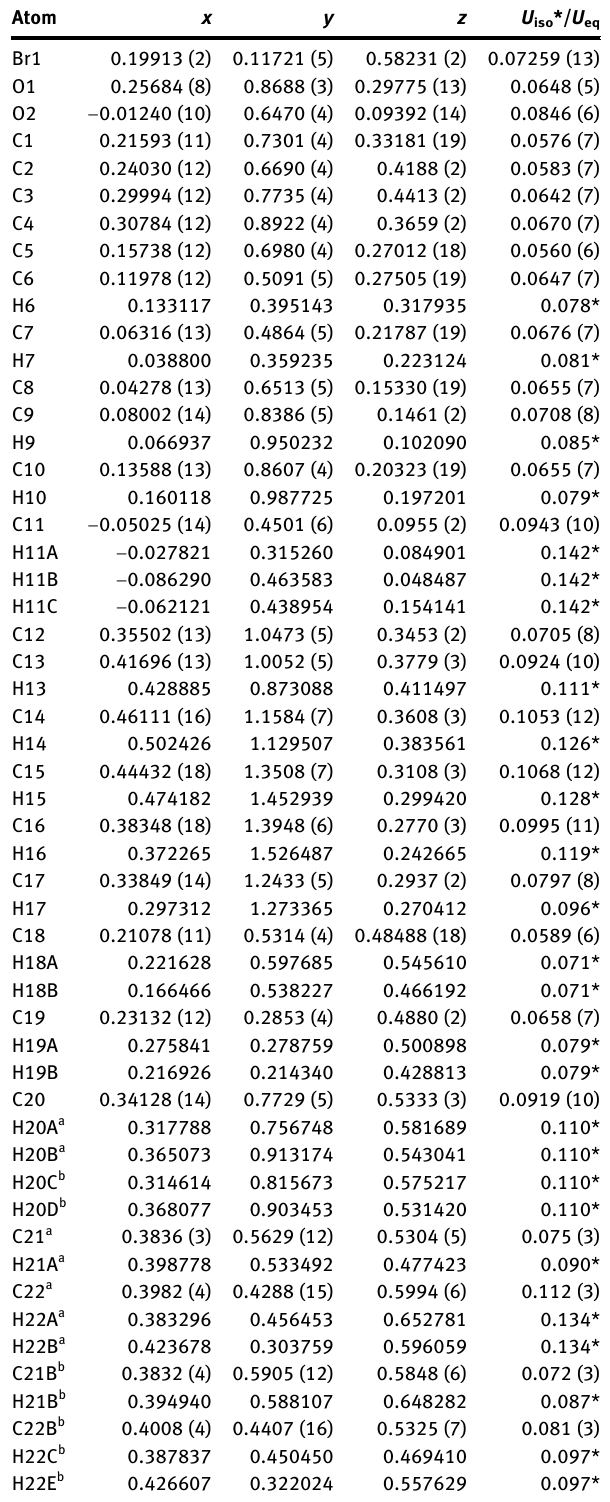
Table  : Fractional atomic coordinates and isotropic or equivalent isotropic displacement parameters (Å 